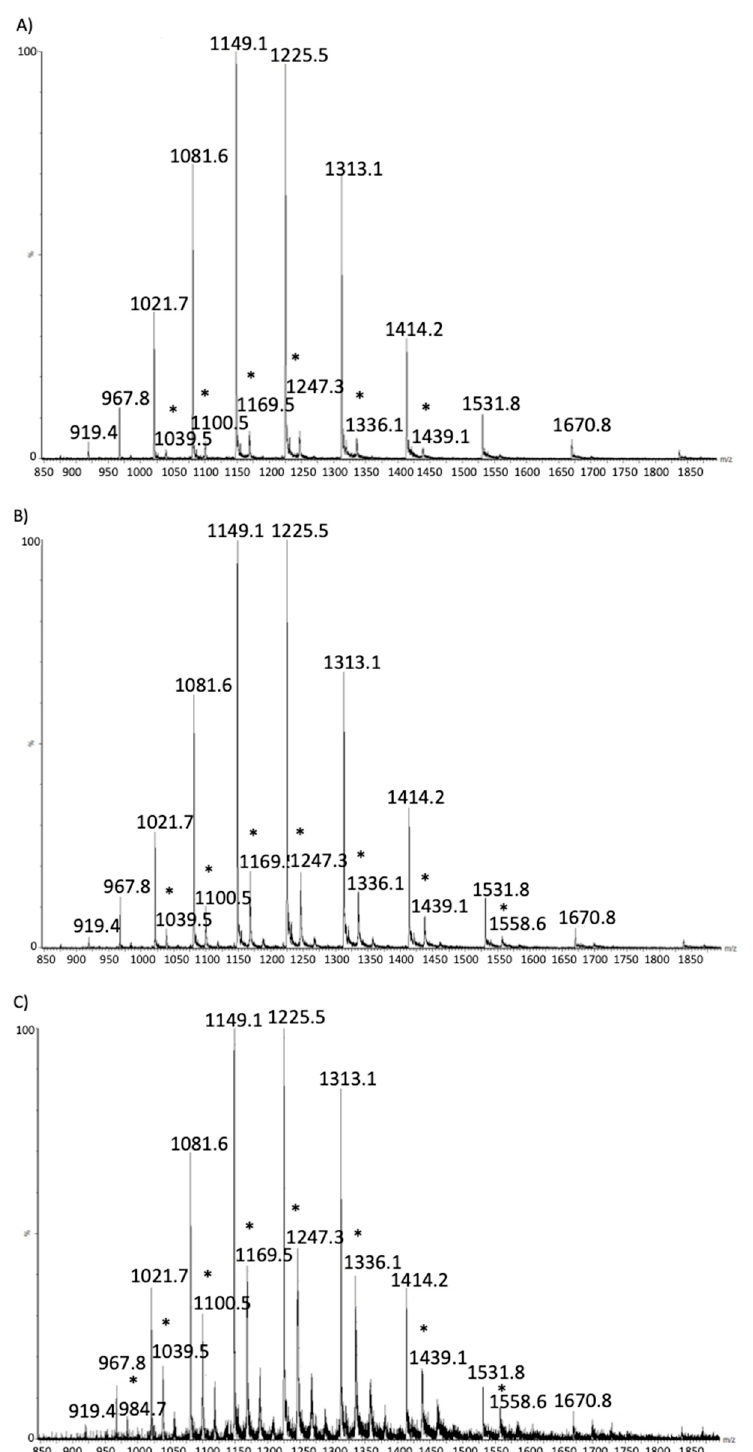
Figure 1. β -lactoglobulin. MS spectrum from raw ( A ), pasteurized ( B ) and Ultra High Temperature (UHT) samples ( C ). Star highlights MS ions corresponding to the lactosylated form of the proteins. Intensity is on the y axis, while m / z on the x axis.